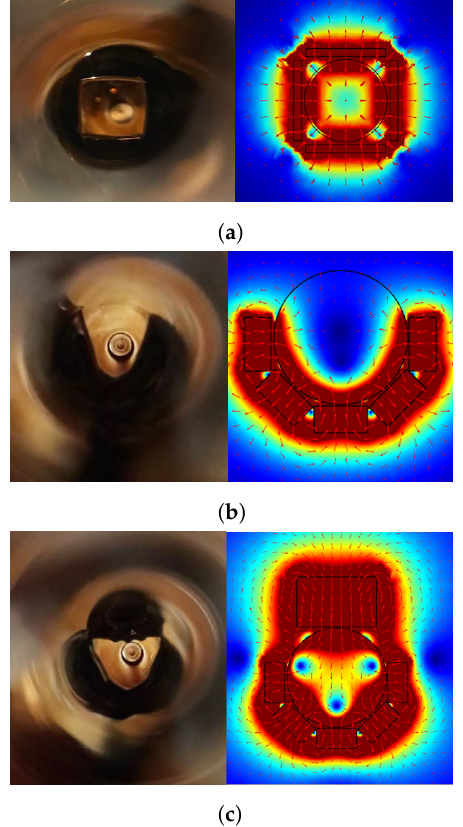
Figure 11. Geometry control of ferrofluid. ( a ) Square-shape ferrofluid. ( b ) ‘U’-shape ferrofluid. ( c ) Triangle-shape